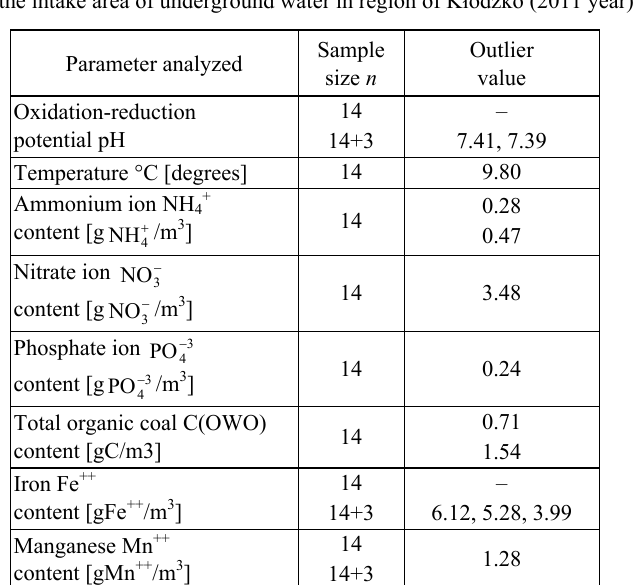
Table 5. A comparison of outlier values of quality